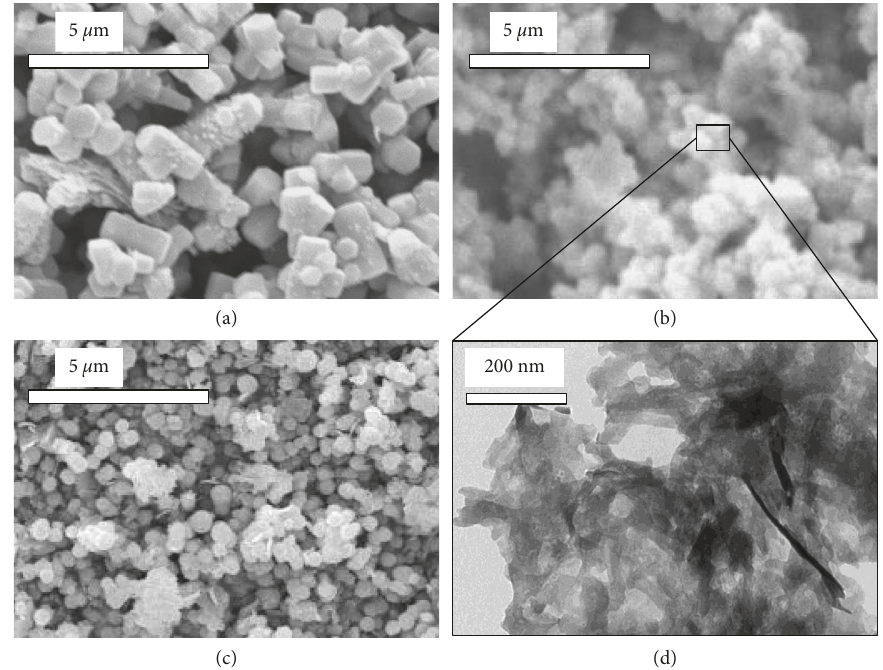
Figure 2: SEM images of ZnO nanoparticles obtained by using (a) 0.1M, (b) 0.05M, and (c) 0.02M zinc acetate. (d) TEM image of ZnO